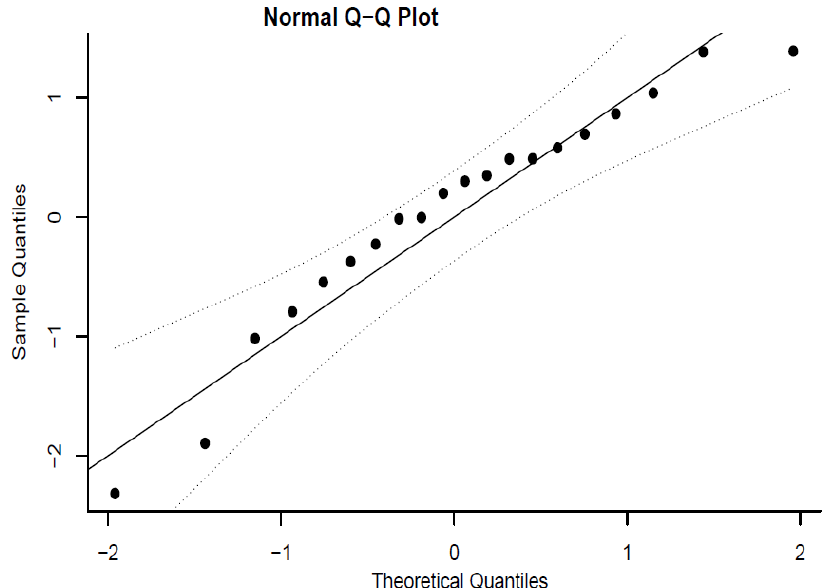
Figure 8. QQ plot with weight as moderator (mixed effects